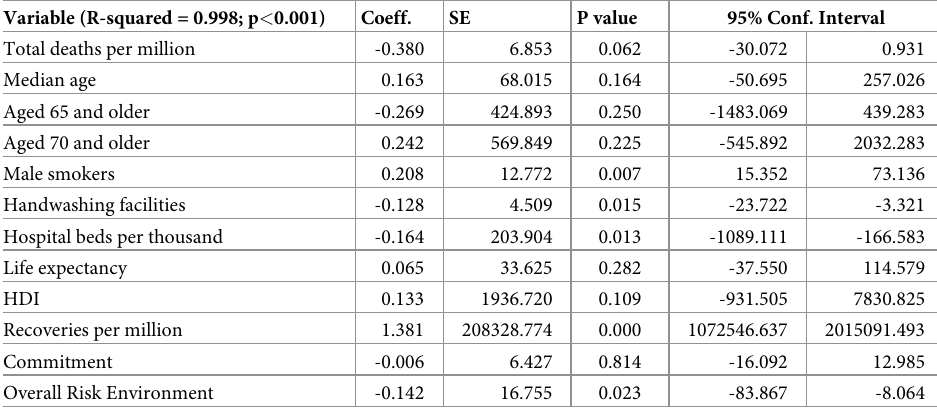
Table 2. Linear regression (multivariable) of total cases per million and predictor variables. Variable (R-squared = 0.998; p < 0.001) Coeff. SE P value 95% Conf. Interval